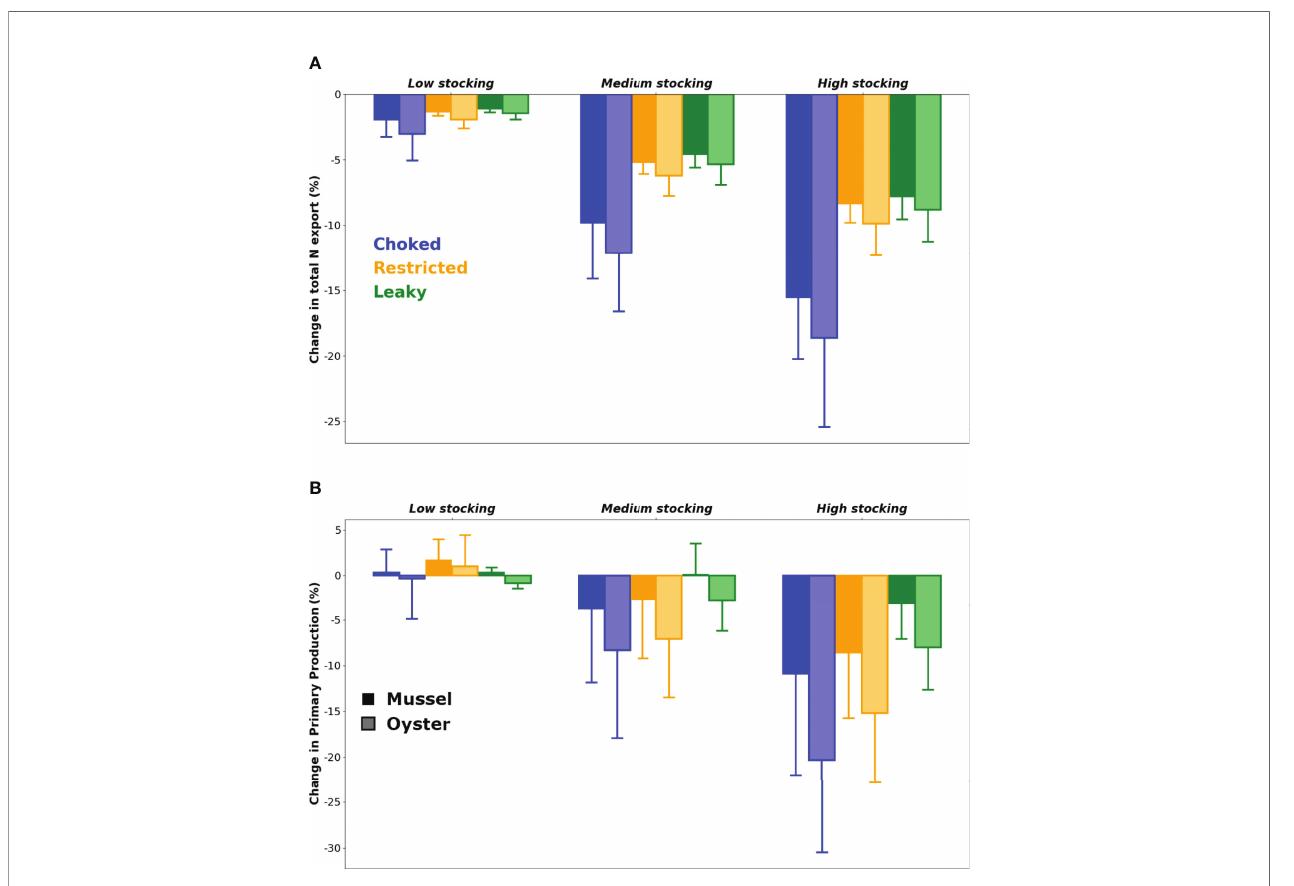
FIGURE 3 | Mean ( ± SD) relative changes in (A) total nitrogen export to the coastal ocean and (B) primary production, following the introduction of various cultured bivalve species at various stocking surface areas in the three bay types. Error bars represent variability introduced by other factors ( i.e. nutrient loading and